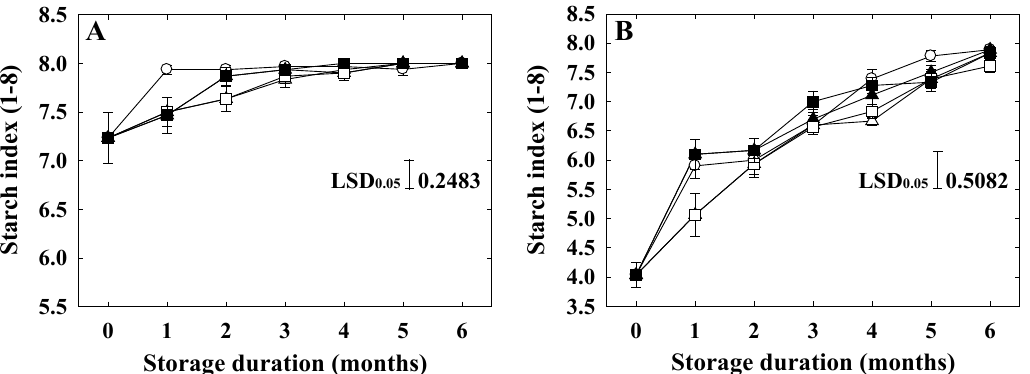
Figure 4. Starch index of ‘Arisoo’ ( A ) and ‘Picnic’ ( B ) apples during cold storage at 0 ± 1 °C with 90–95% relative humidity for up to six months. Fruits were treated with 0.5 μL L −1 1- MCP (∆) and 1 μL L −1 1-MCP ( ▲ ) at harvest, and 0.5 + 0.5 μL L −1 1- MCP (□) and 1 + 1 μL L −1 1-MCP ( ■ ) at harvest and 2 months after storage, and untreated as control ( ○ ). Data are presented as mean ± standard error ( n = 15).